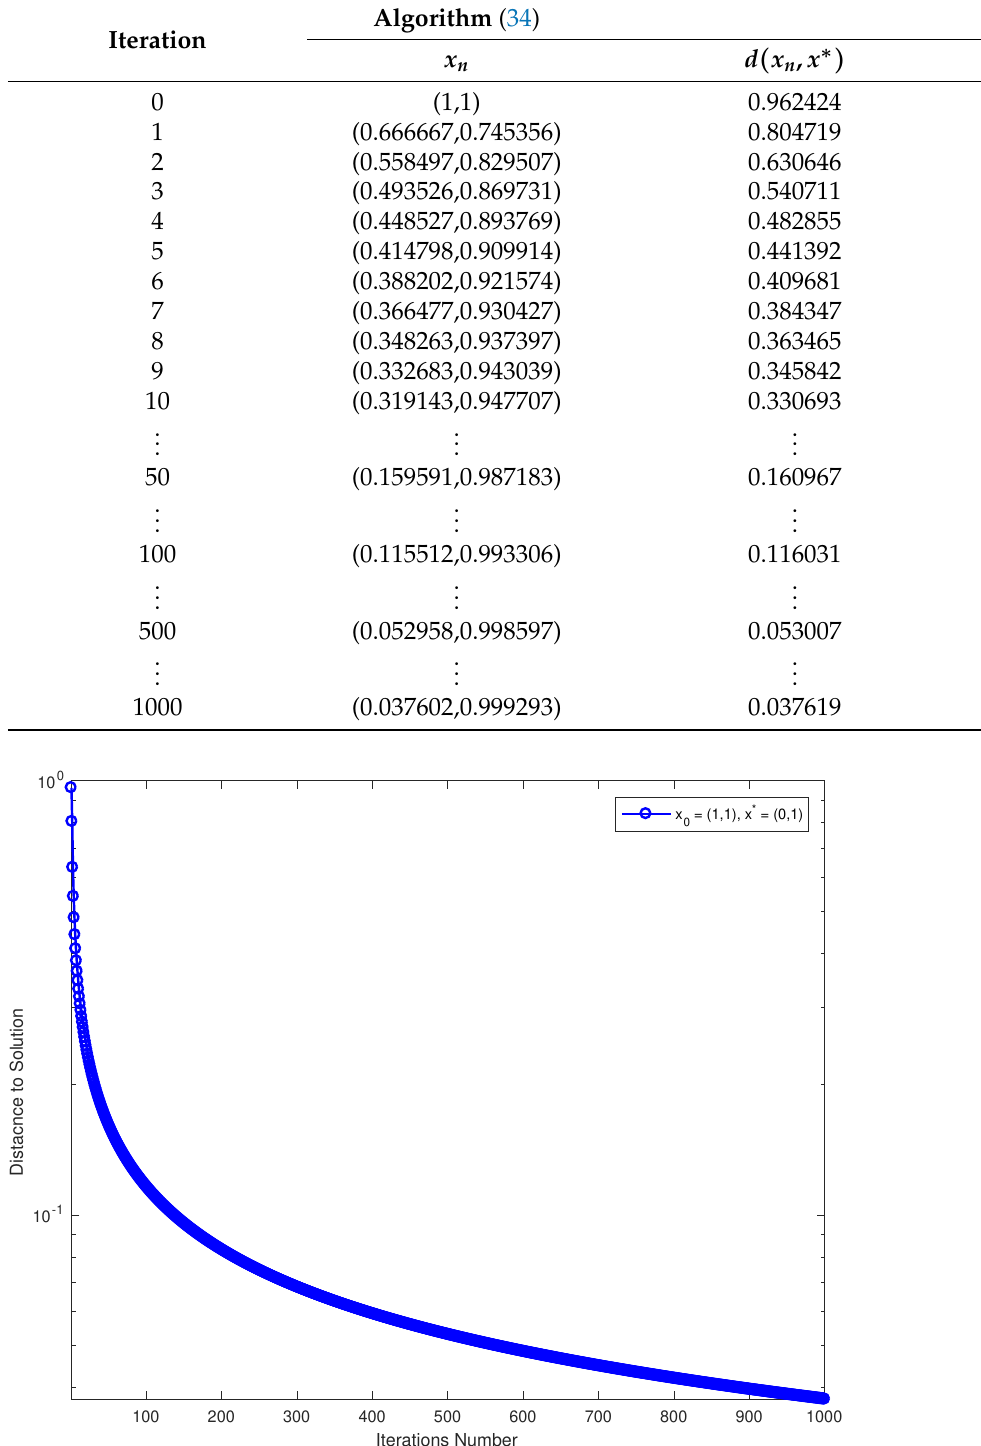
Figure 4. Distance to solution x ∗ = ( 0,1 ) of each iteration number where the initial point is x 0 = ( 1,1 )